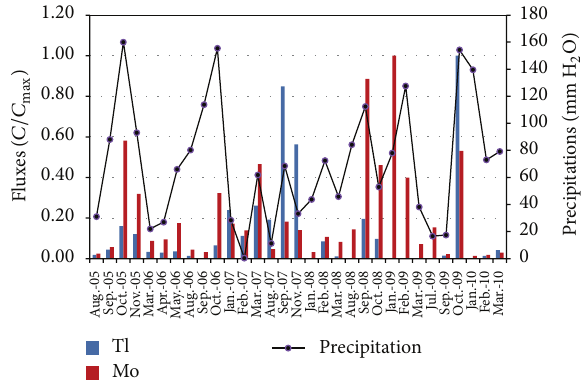
Figure 6: Fluxes of thallium and molybdenum and precipitations in D4 from August 2005 to March